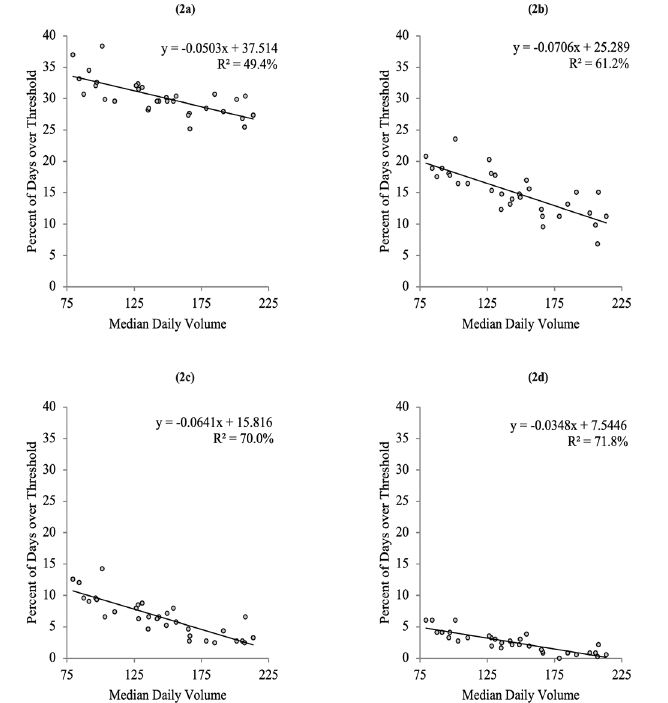
Figure 2. Regression analysis results: The percent of days exceeding specified thresholds vs daily median volume (2a: 5% above median volume, 2b: 10% above median volume, 2c: 15% above median volume, 2d: 20% above median volume). The data in all four charts indicate a negative slope, demonstrating that smaller emergency departments (ED) tend to cross percent- of-median volume thresholds more frequently than larger EDs. In